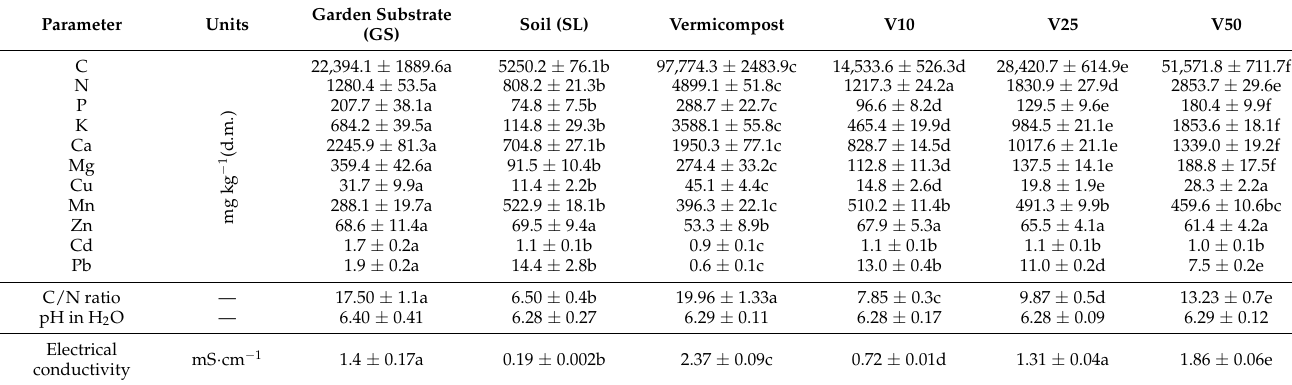
Table 1. The content of macronutrients and microelements in the given growth media—details in text (mean ± standard deviation based on five